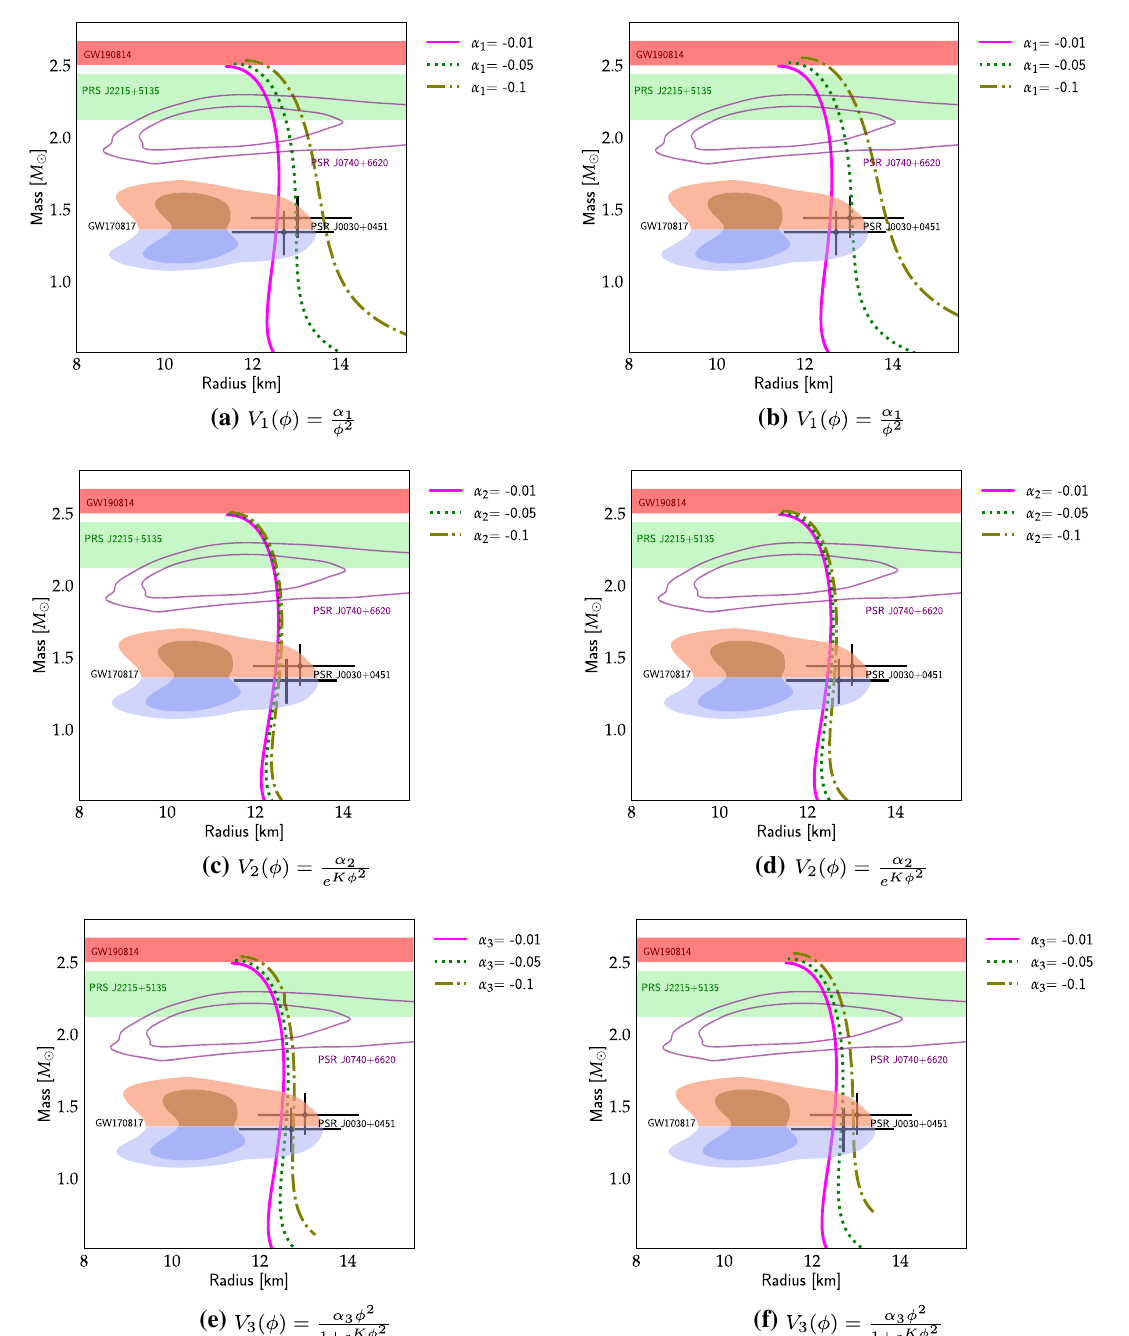
Fig. 3 The mass–radius relation of neutron stars in mimetic gravity for MPA1 EoS. φ( 0 ) = 1: left panels and φ( 0 ) = 0 . 8: right panels and K = 0 .